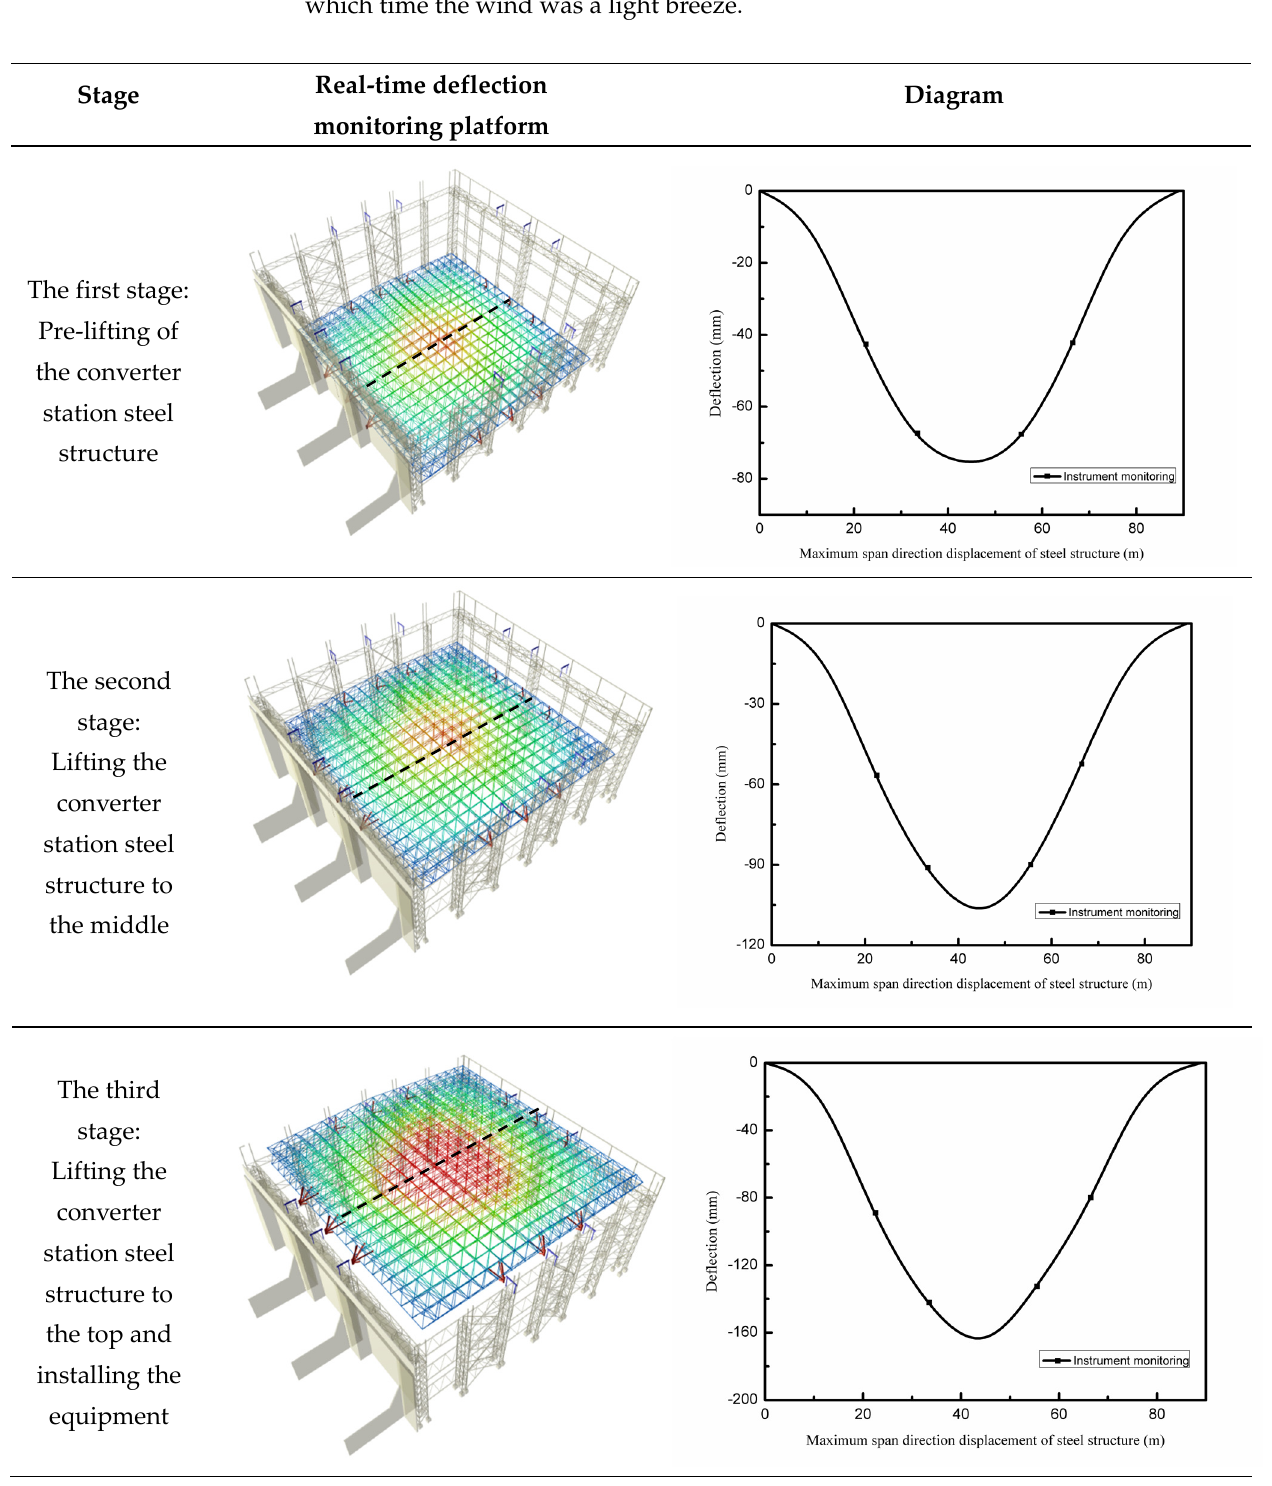
Figure 23. Three − dimensional, real − time monitoring.